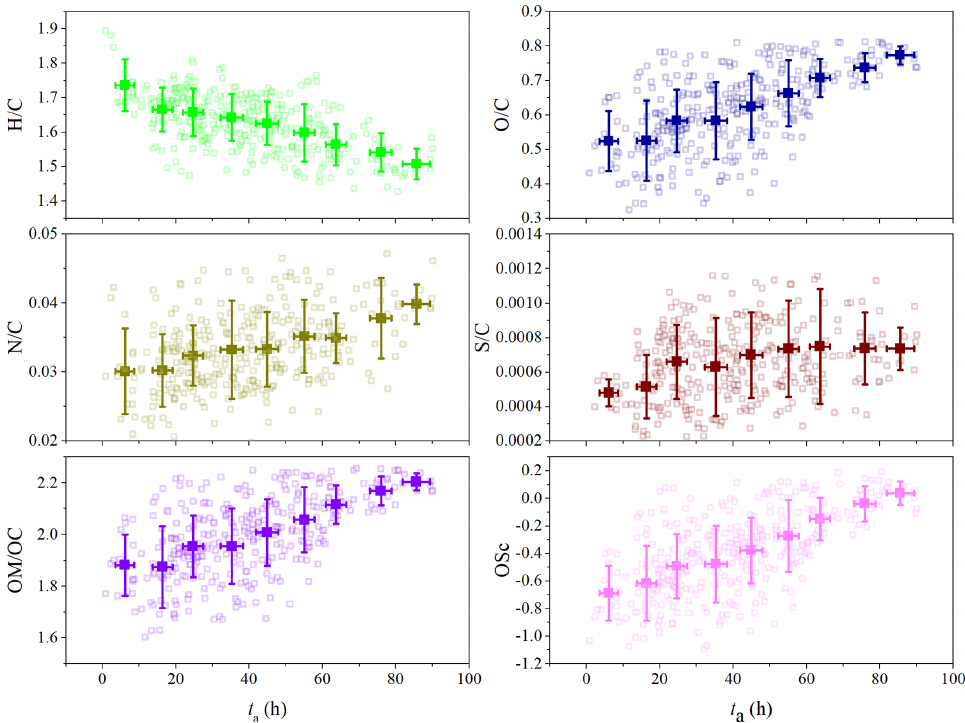
Figure 6. Variations of H / C, O / C, N / C, S / C, OM / OC, and OSc as a function of t a . The data are binned according to the value of t a (10h increments).